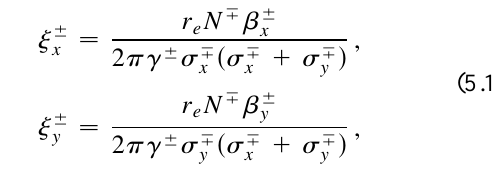
TABLE I. Parameters for the beam-beam simulation.